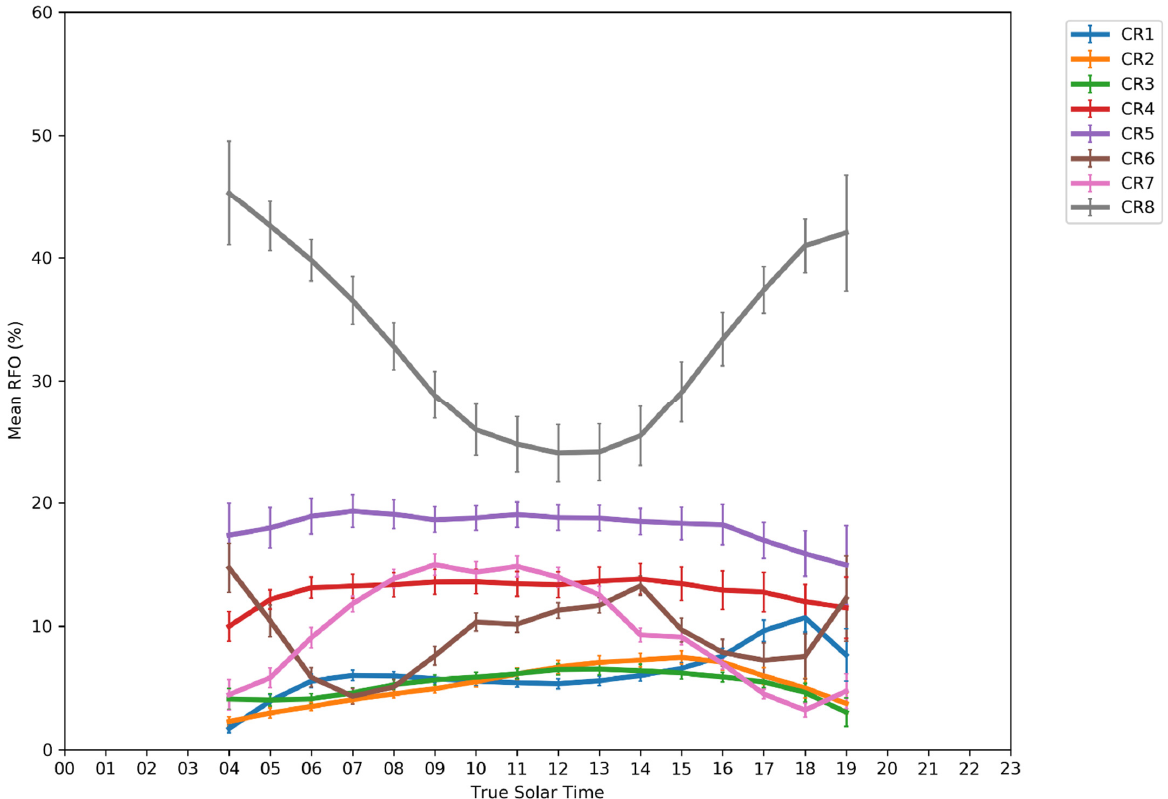
Figure 10. Similar to Figure 5 but for the region of